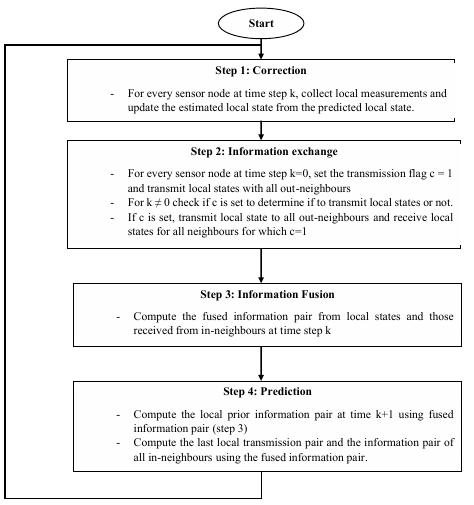
Figure 3. Flow diagram of implemented distributed Kalman filter algorithm.